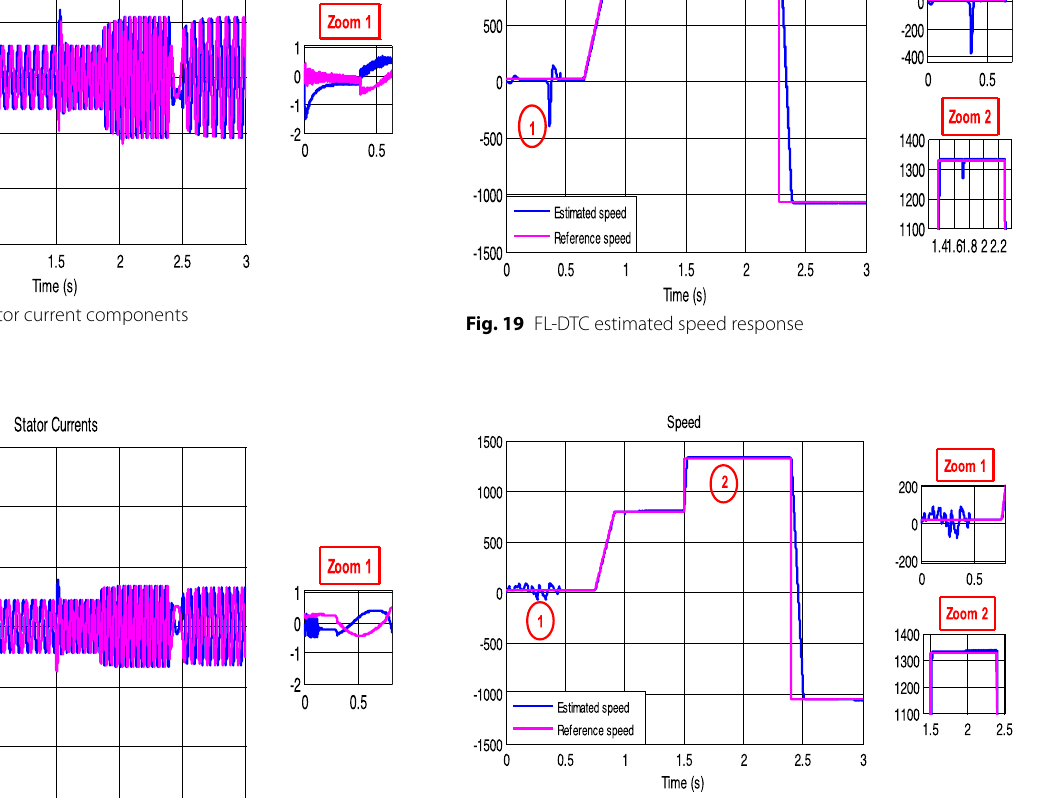
Fig. 20 PI-DTC-SPWM with three-level inverter estimated